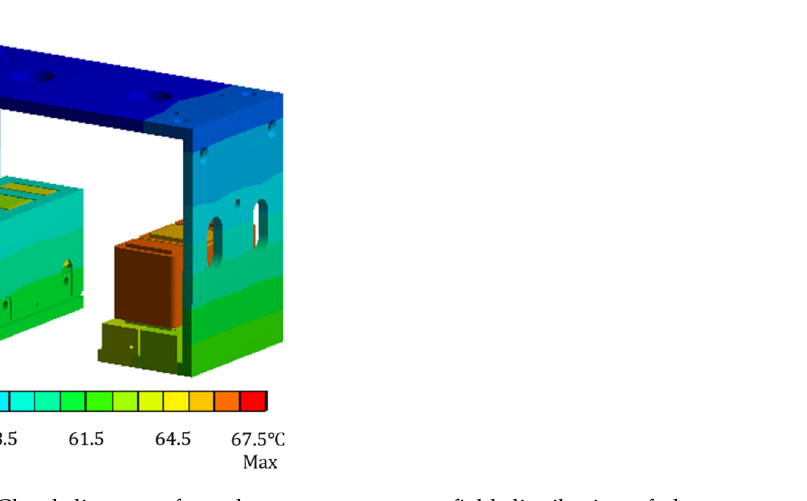
Table 3. Maximum temperature of electromagnet with suspension support under different currents.